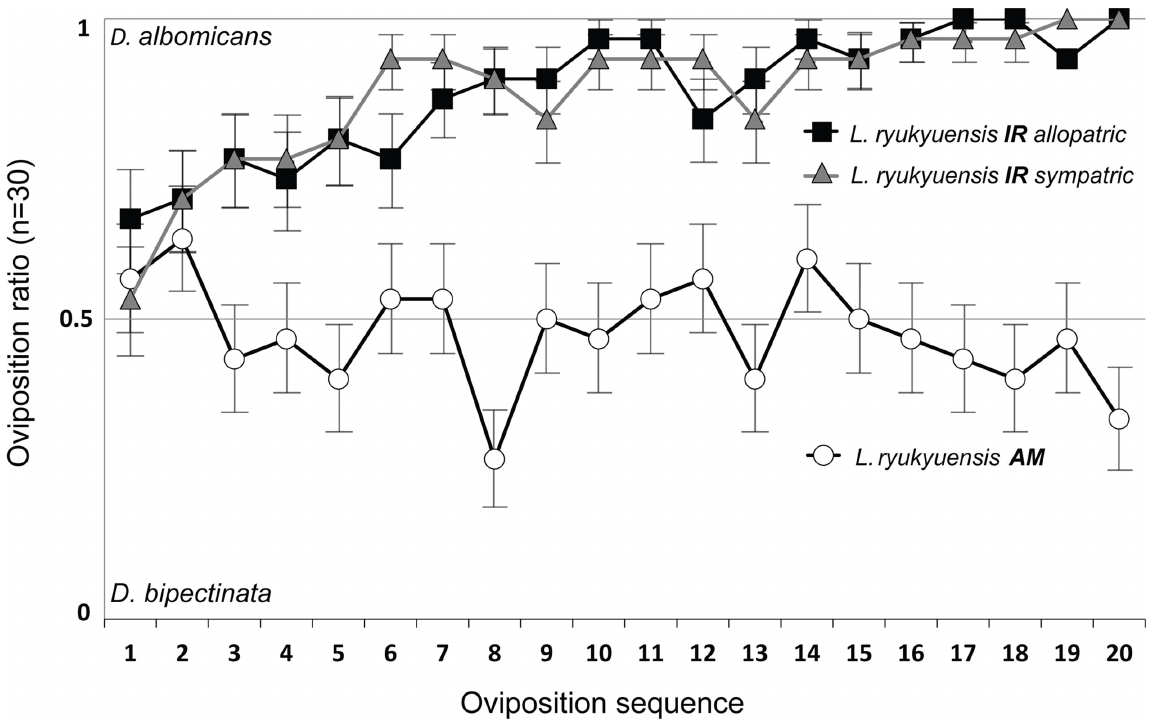
Fig 6. Oviposition sequences of AM and IR strains of L . ryukyuensis . Marks indicate the departure from the 0.5 line which represents the same probability of D . albomicans or D . bipectinata larvae being chosen for oviposition. Each mark represents the ratio derived from the observation of 30 wasps. Numbers 1 and 20 on the horizontal axis represent the first and the last observed oviposition, respectively. (white circles) AM wasps ovipositing in NH fly strains, (black squares) IR wasps ovipositing in NH fly strains, (gray triangles) IR wasps ovipositing in IR fly strains.